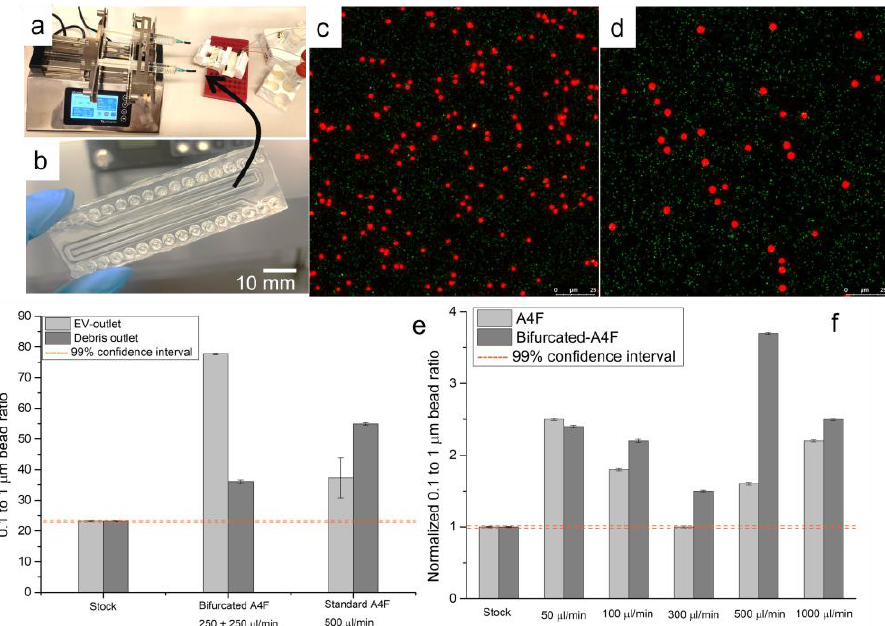
Figure 9. Bifurcated A4F experiments with control particles. ( a ) Experimental setup with a syringe pump and resistances in the ports to equalize hydraulic resistances of outlets. ( b ) Fabricated A4F device with meandering design for increased total length in the channels. ( c ) A sample image of overlaid red and green channels for 1 µm and 100 nm bead from confocal microscopy, image from the stock prior to experiments. ( d ) A sample image of overlaid red and green channels for 1 µm and 100 nm bead from confocal microscopy, image from bifurcated A4F experiment with 1 mL/min flow rate. In the bifurcated A4F beads experience 1 in 2 dilutions with respect to stock ( e ) Ratio of 100 nm to 1000 nm beads in both particle outlets of the chip for bifurcated A4F and standard A4F experimental setup. ( f ) A sweep of flow rates for bifurcated and standard A4F setup with stock-normalized 100 nm bead plot.